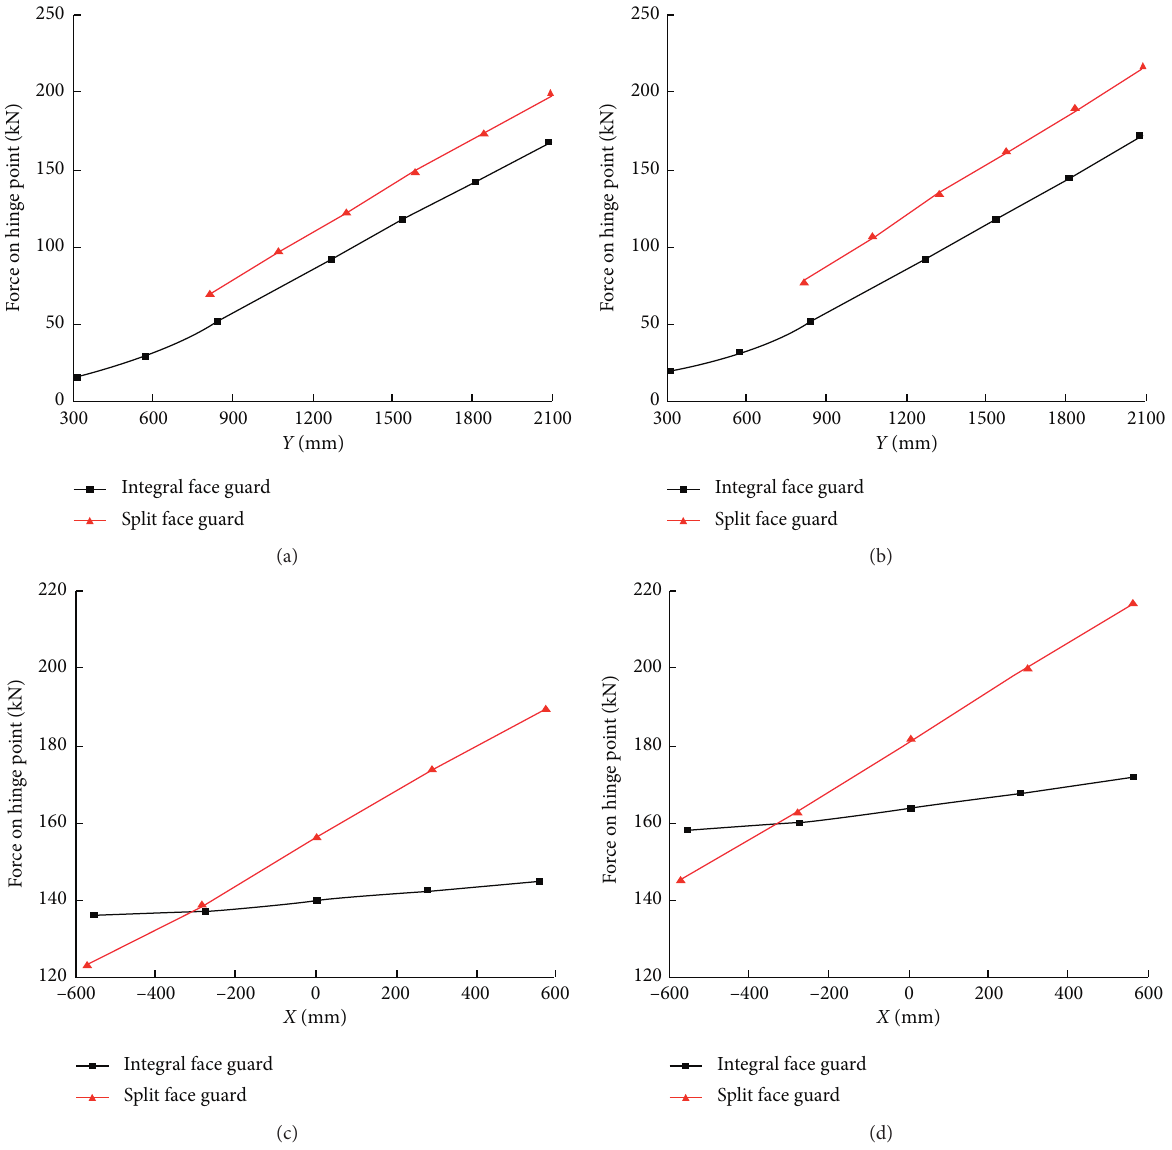
Figure 17: Comparison of the bearing characteristics of different positions of face guard. (a) Coordinate value of X -axis is 280mm. (b) Coordinate value of X -axis is 560mm. (c) Coordinate value of Y -axis is 1800mm. (d) Coordinate value of Y -axis is